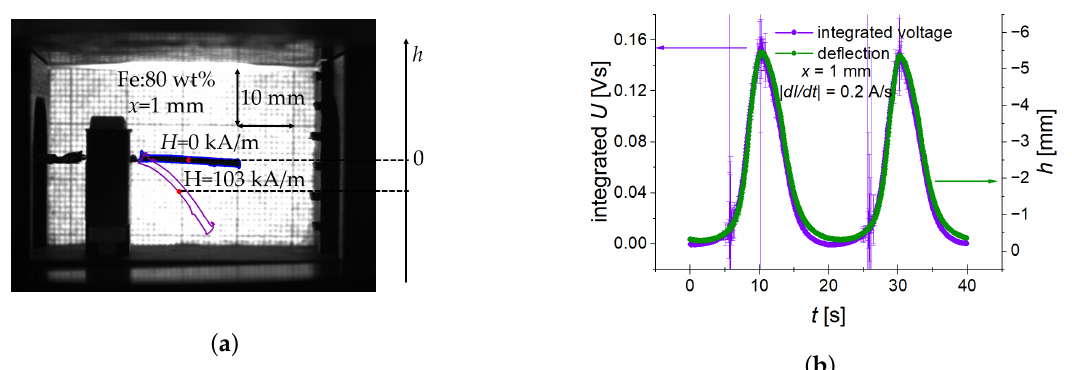
Figure 2. ( a ) Example of determining the deflection h from measurements of the cantilever’s “mass centre” [24]. ( b ) Comparison of the numerically integrated output voltage U (purple line) and the deflection h (green line) for the case of a slew rate of 12.2 kA/sm and x = 1 mm.